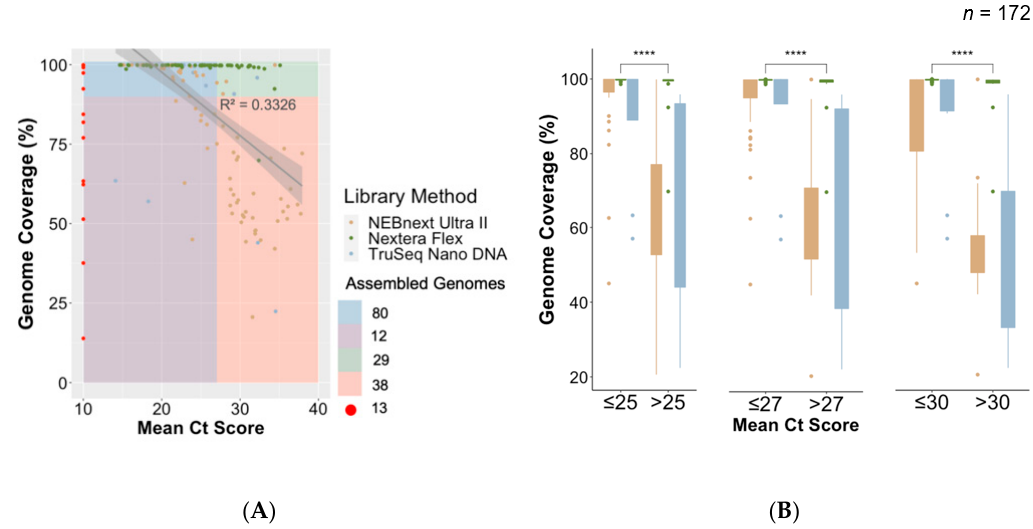
Figure 4. Association between Ct value and genome length by library preparation method. ( A ) Regression plot of mean Ct value of all unique samples against their genome lengths (% coverage against SARS-CoV-2 reference). Samples with missing Ct value information ( n = 8) are shown in red. A total of 114 assembled genomes of >90% were produced (80 with Ct value <27, 29 with Ct value >27, and five with missing Ct values). ( B ) Box plot and statistical comparison of genome coverage obtained from samples grouped in three mean Ct value thresholds (25, 27, and 30) by library preparation method, showing statistically significant ( t -tests) differences between lower and higher Ct value samples. ****: level of significance